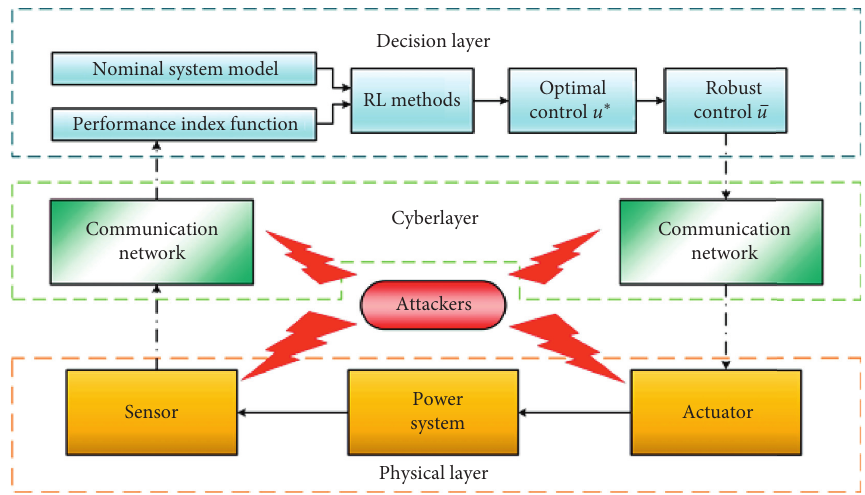
Figure 1: Block diagram of proposed robust